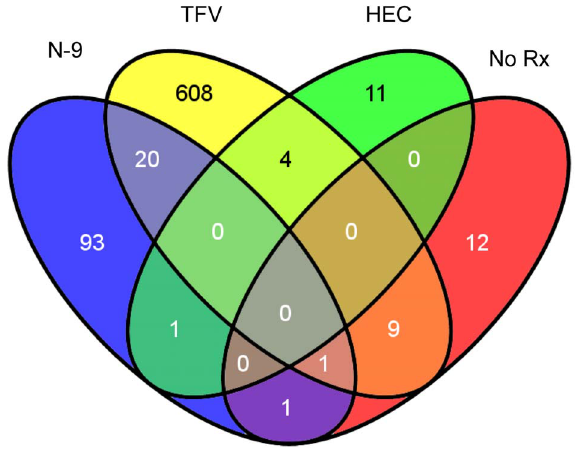
Figure 2. Number of genes in rectal biopsies (9 cm) with significant expression changes between baseline and after 7 days of treatment. The four ellipses represent each of the four treatment arms, Nonoxynol 9 (N-9) gel, tenofovir (TFV) gel, hydro- xyethylcellulose (HEC) gel or no gel (No Rx). The numbers of genes changing expression exclusively in one study arm are indicated in fields of the diagram that do not overlap with another field (N-9, 93 genes; TFV, 608 genes; HEC, 11 genes; No Rx 12 genes). When identical genes changed in more than one treatment arm, their number is placed into the respective overlapping fields of the diagram. Choice of colors is arbitrary to help visually distinguish each separate field of the diagram. cRNA preparation, gene chip hybridization, and data significance analysis was carried out as described in the Materials and Methods section of the paper.